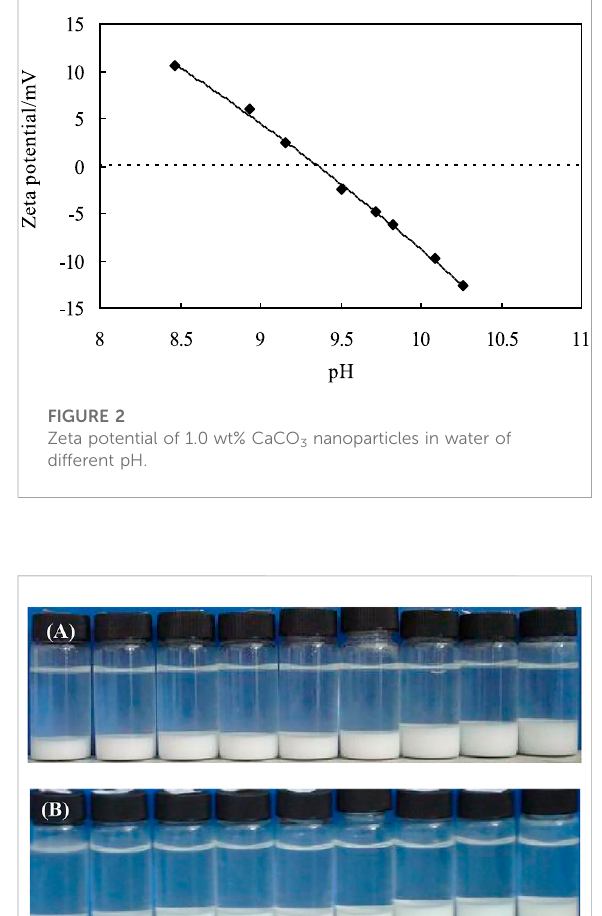
FIGURE 3 Appearance of 1.0 wt% CaCO 3 nanoparticles dispersed in aqueous solutions with HCl or NaOH at different concentration (fromlefttoright)(HCl)1×10 − 2 ,1×10 − 3 ,1×10 − 4 ,and1×10 − 5 mol/L,